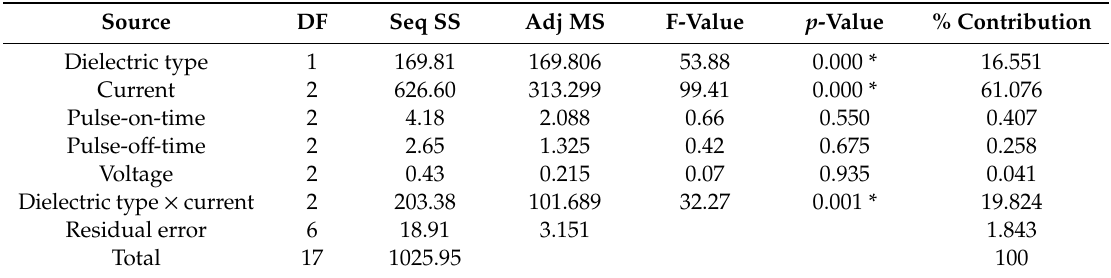
Table 7. Analysis of variance for signal-to-noise ratios of Surface Roughness.